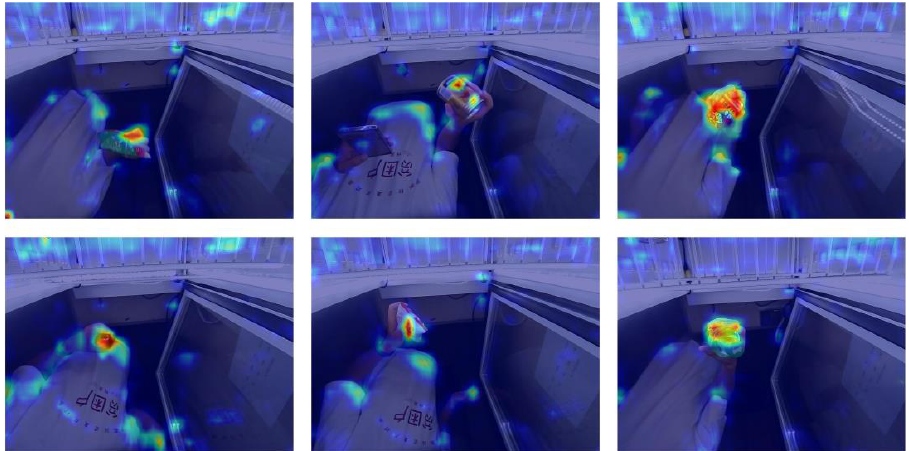
Figure 15. Feature-enhanced visualization.